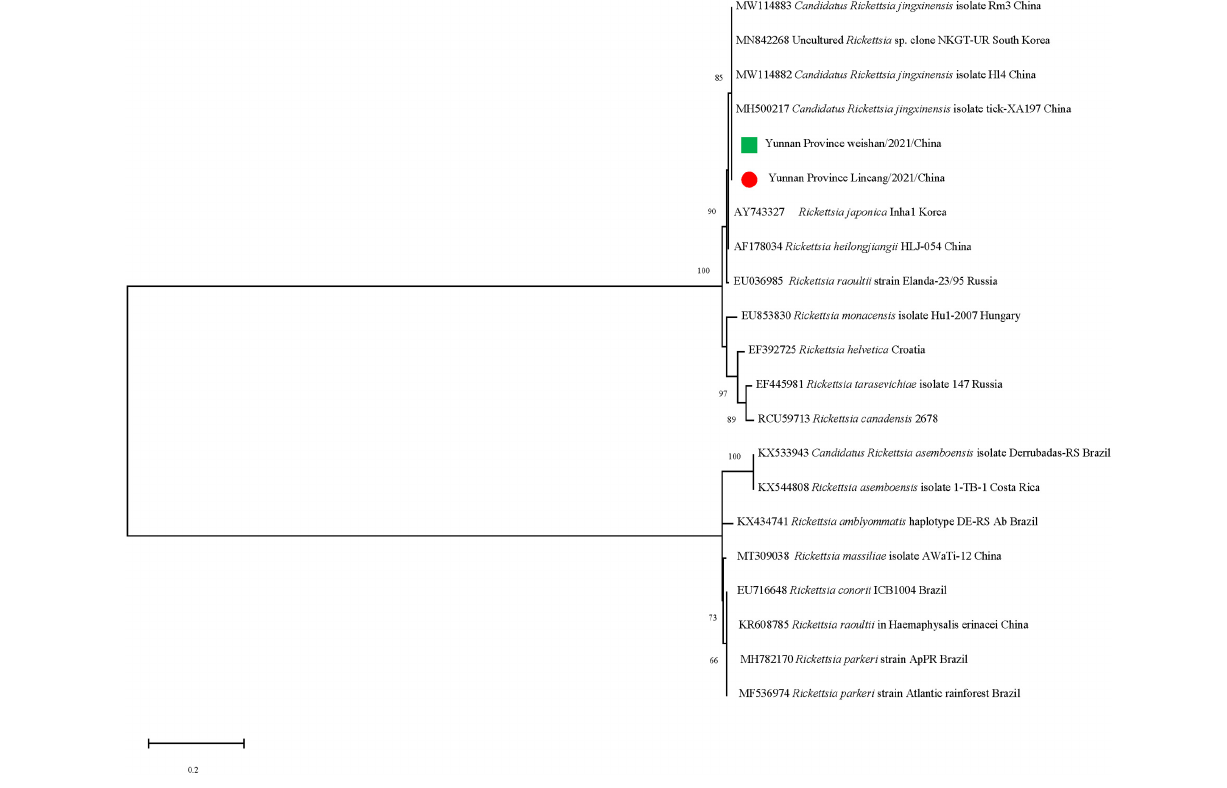
FIGURE 3 | Phylogenetic tree of Candidatus Rickettsia jingxinensis in ticks based on partial gltA gene sequence similarity. The sequences obtained in this study are indicated with a colored dot. Sequences were aligned using the MEGA X (Version 10.2.5) software package. Phylogenetic analysis was performed by the maximum likelihood method, and bootstrap values were estimated for 1,000